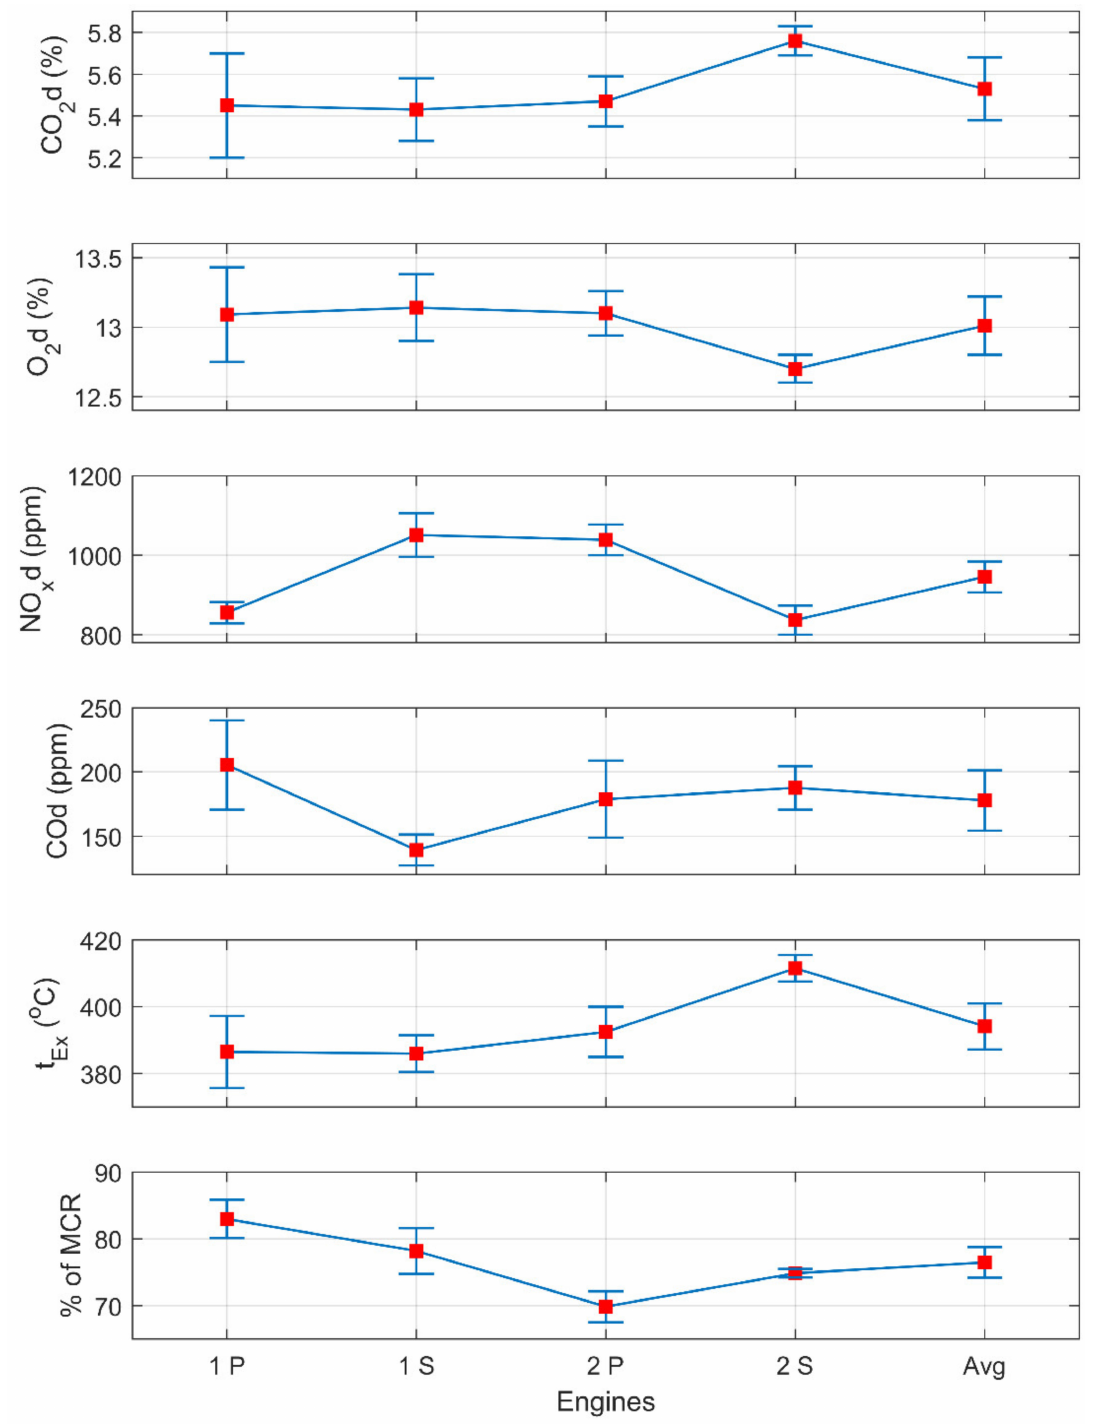
Figure 7. Mean µ and standard deviation σ of measured and analysed parameters for Vessel 1 and its associated port (P) and starboard (S) engines with calculated average